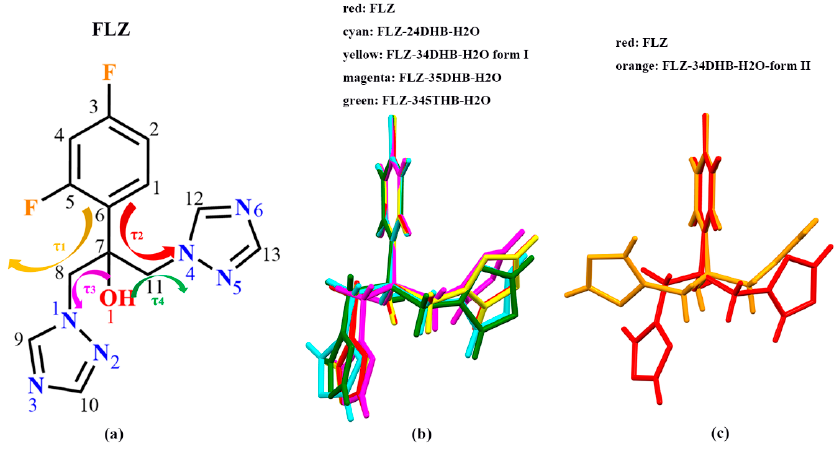
Figure 7. ( a ) Molecular diagram of fluconazole (FLZ). Four torsion angles: τ 1 = C 6 − C 7 − C 8 − N 1 , τ 2 = C 6 − C 7 − C 11 − N 4 , τ 3 = O 1 − C 7 − C 8 − N 1 , τ 4 = O 1 − C 7 − C 11 − N 4 . ( b , c ) Structure Overlay of FLZ conformations in the FLZ pure drug (form II) and its cocrystal hydrate forms. Table 2. Torsion angles of FLZ and its cocrystal hydrates.